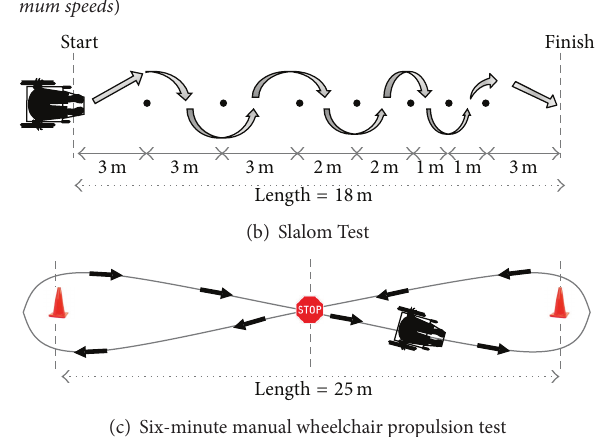
Figure 1: Schematic drawings of the manual wheelchair propulsion